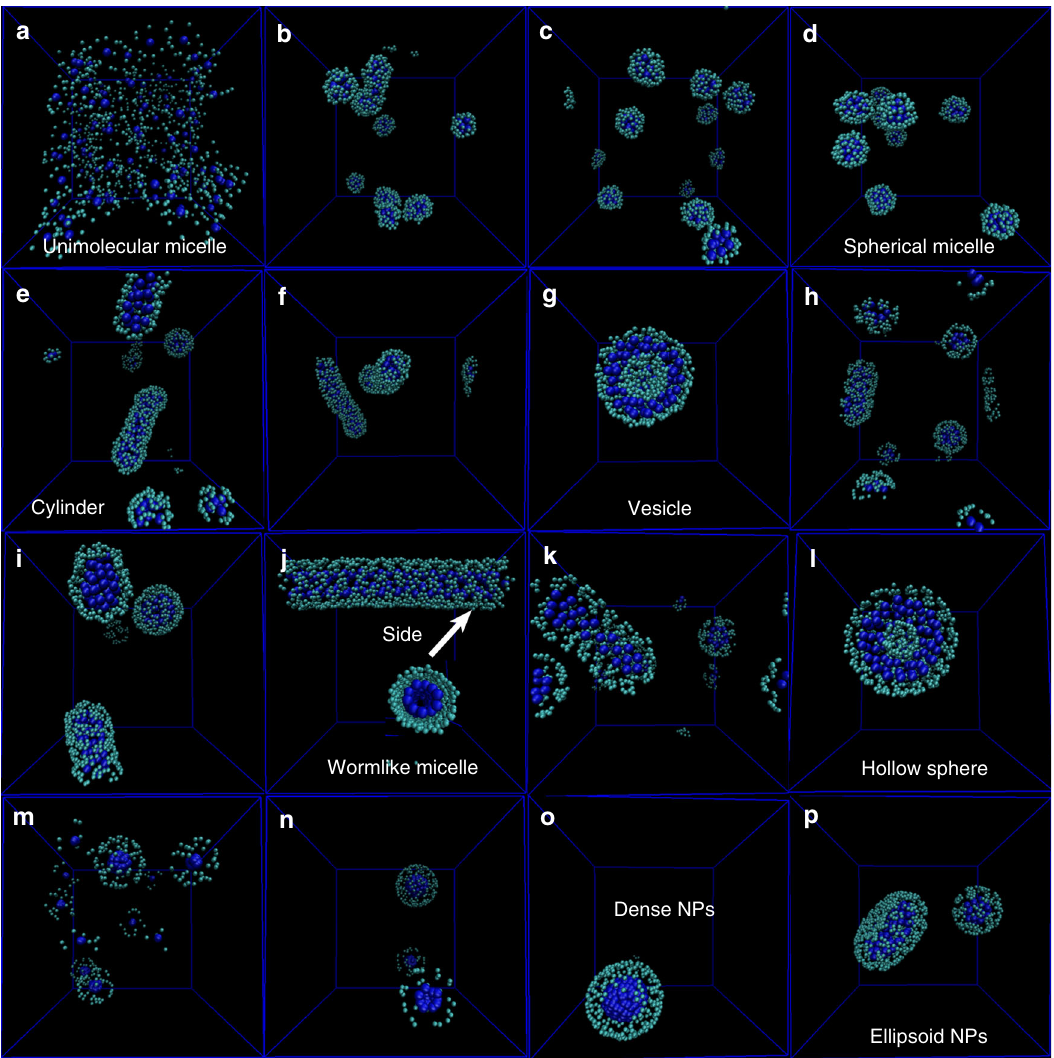
Fig. 9 DPD simulations showing the formation pathway and morphology evolution of self-assemblies. a Unimolecular structure, b – d spherical structures, e cylindrical structures, f intermediate structures from cylinders to vesicles, g vesicular structures, h , i intermediate structures from vesicles to worm-like micelles, j long worm-like structures, k curved worm-like structures, l hollow spherical structures, m – o intermediate structures of dense nanoparticles, and p ellipsoid nanoparticle structures. The water beads are omitted for clarity (see Methods section for the detailed simulation